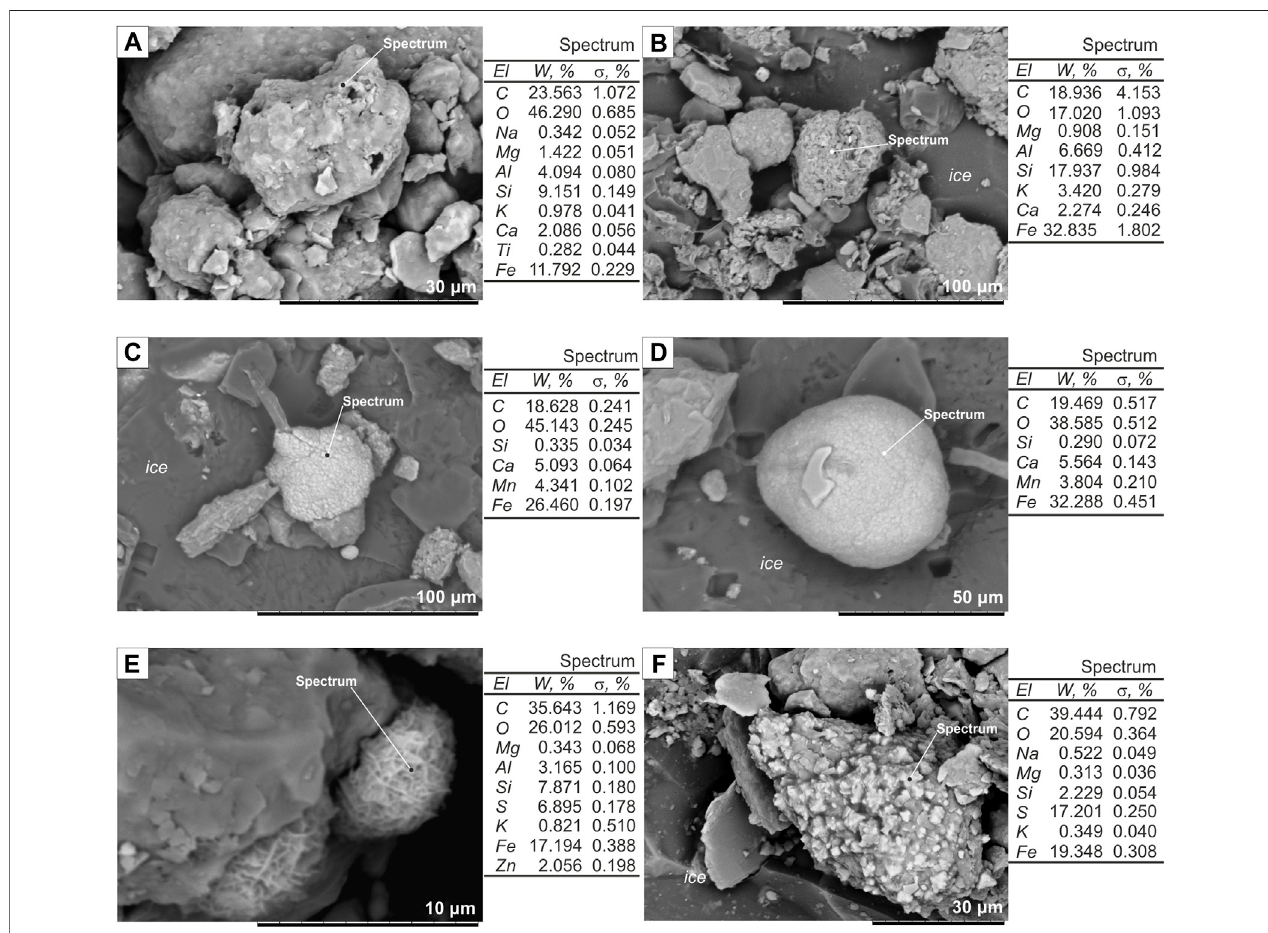
FIGURE 4 | Cryometamorphic features: (A) Fe-colloidal fi lm on mineral grain surface, Kur ’ ishka site, sampled at 15 m arl; (B) aggregate cement, Plakhinskii Yar site, sampled at 12 m arl; (C) colloidal siderite around fungal hyphae, Zelyony Mys site, sampled at 35 m arl; (D) siderite concretion, Zelyony Mys site, sampled at 35 m arl; (E) amorphous iron sul fi de (FeSam), Kur ’ ishka site, sampled at 21 m arl; (F) octahedral greigites coating a silt particle, Kur ’ ishka site, sampled at 21 m arl.